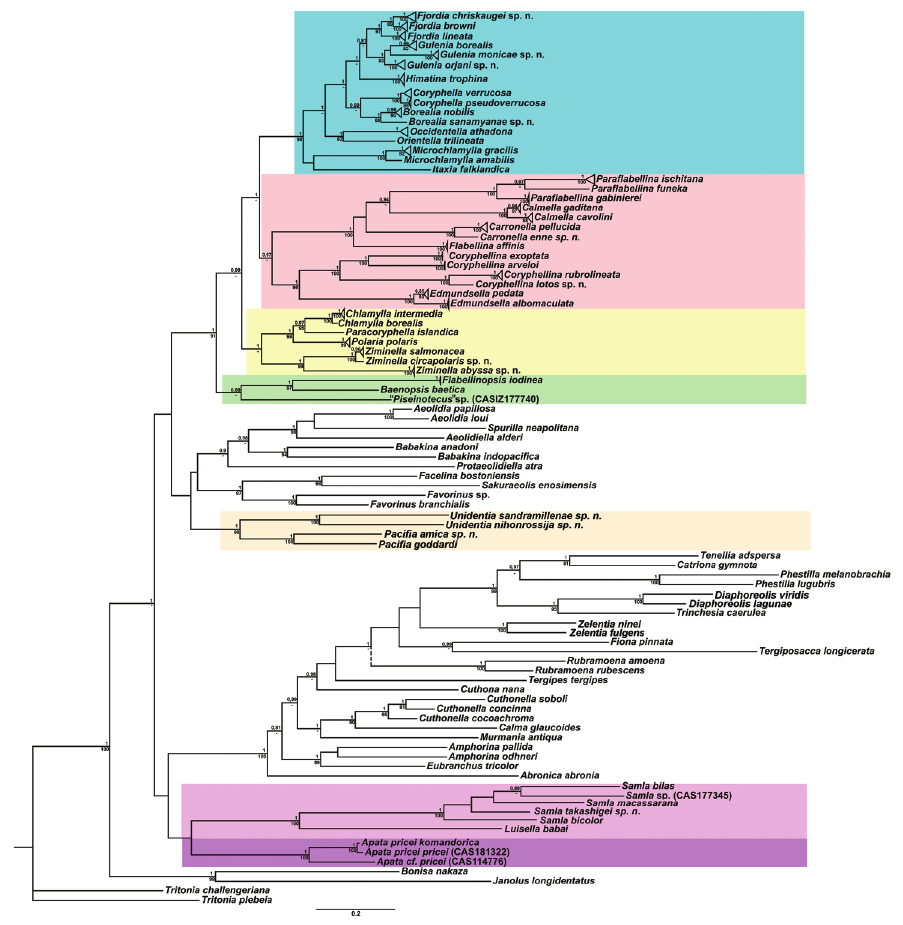
Figure 1. Phylogenetic tree of aeolidacean nudibranchs based on concatenated molecular data (COI + 16S + 28S + H3) represented by Bayesian Inference (BI). Numbers above branches represent posterior probabilities from Bayesian Inference. Numbers below branches indicate bootstrap values for Maximum Likelihood. Some branches are collapsed at species level. The “Flabellinidae” polyphyletic family complex is highlighted by different colours (see Fig. 2 for the family